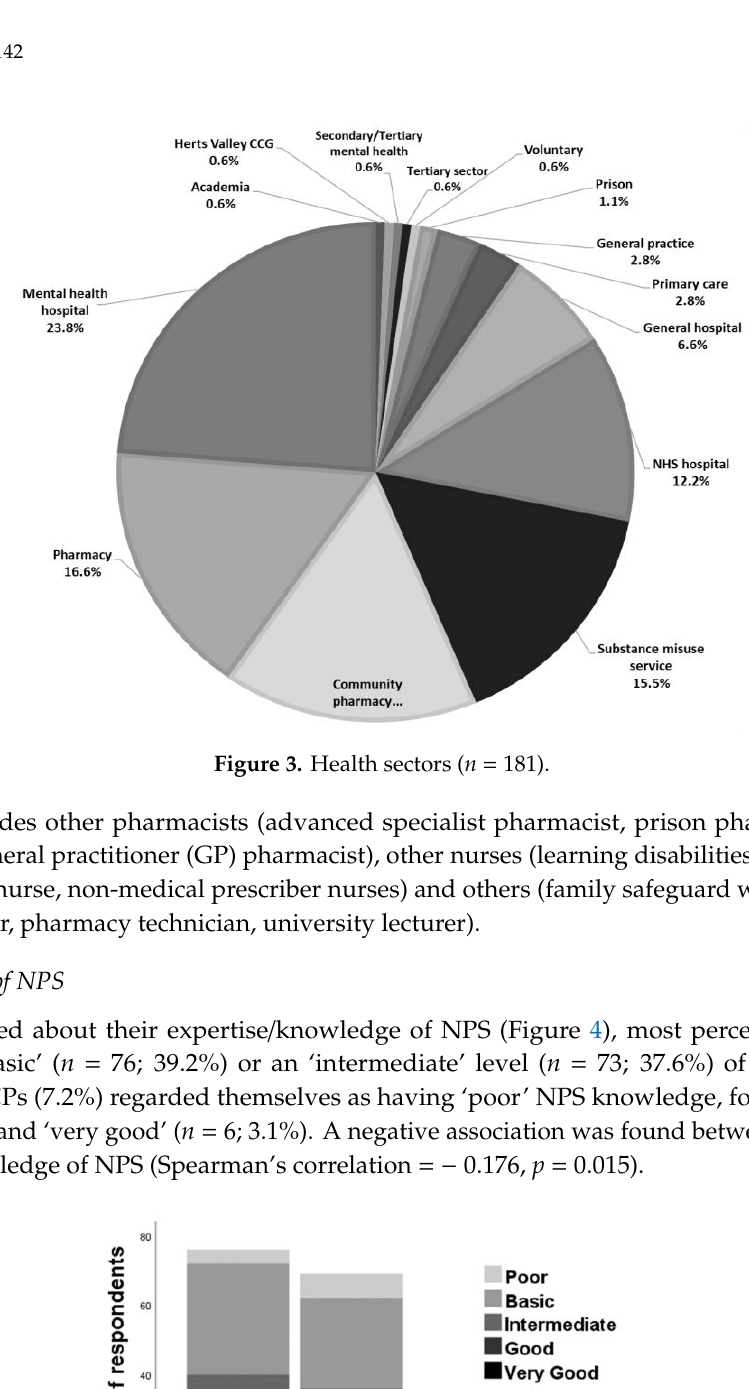
Figure 2. Profession types ( n = 186).